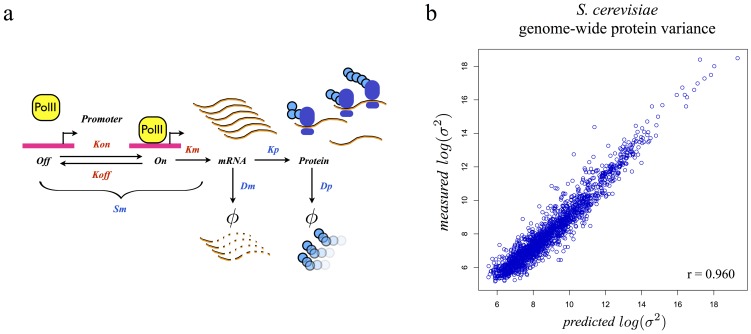
Stochastic model of gene expression: a) Schematic representation of the model.Each step transition is determined by a rate constant. Promoter activation and inactivation occur at Kon and Koff rates respectively. When active, a promoter is transcribed at Km rate into an mRNA molecule. The mRNA molecule can then be either degraded at Dm rate or translated at Kp rate into a protein. The protein molecule can then be degraded at rate Dp. Kon, Koff, and Km determine the synthesis rate of mRNA, or Sm. Blue indicates that the parameter has been empirically measured or calculated across the dataset, red indicates that the parameter has been simplified or fit across the dataset b) Model performance in predicting protein variance in S. cerevisiae. Each point represents a single GFP fusion strain. Data is displayed in log-scale (linear scale r = 0.836).